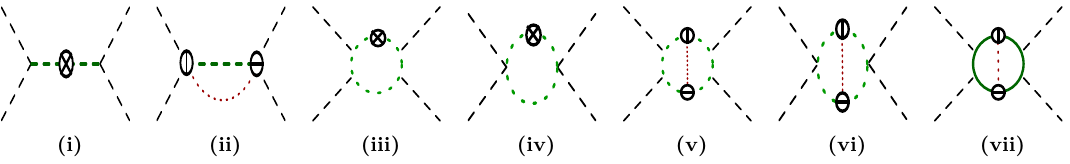
Figure 4 . Tree- (i)–(ii) and one-loop-level (iii)–(v) diagrams built of Lorentz invariant renormal- izable interactions of the UV theory that lead to effective operators of φ 4 D 2 class.